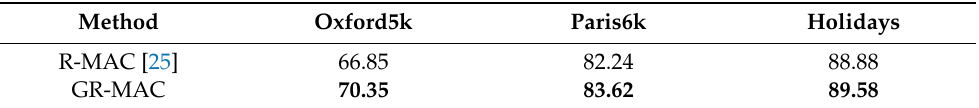
Table 1. Performance (mean average precision (mAP)) comparison between regional maximum acti- vation of convolutions (R-MAC) [25] and generalized R-MAC (GR-MAC) on the Paris6k, Oxford5k, and Holidays data sets. The best result is highlighted in bold.